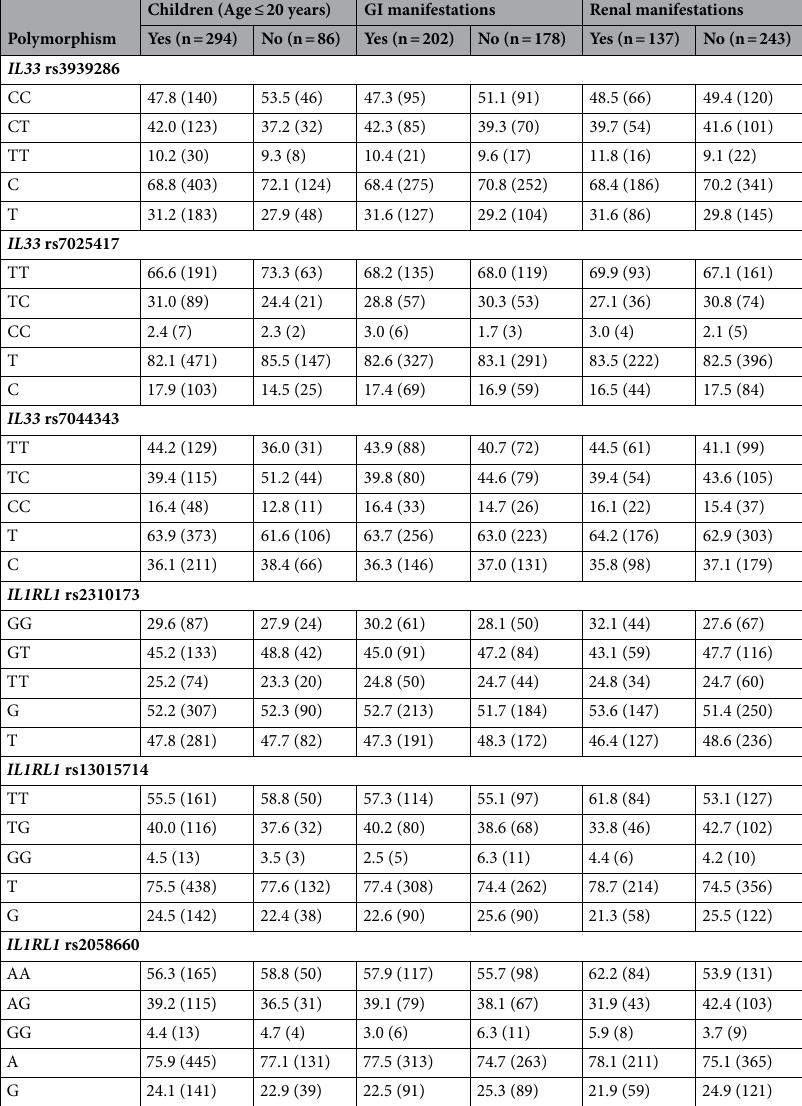
Table 3. Genotype and allele frequencies of IL33 and IL1RL1 genes in patients with IgAV stratified according to clinical characteristics of the disease. IgAV: IgA vasculitis; GI: gastrointestinal. No statistically significant differences in the IL33 and IL1RL1 genotype and allele frequencies were disclosed between patients with IgAV stratified according to the age at disease onset, the presence/absence of GI or renal manifestations ( p ≥ 0.05 in all the